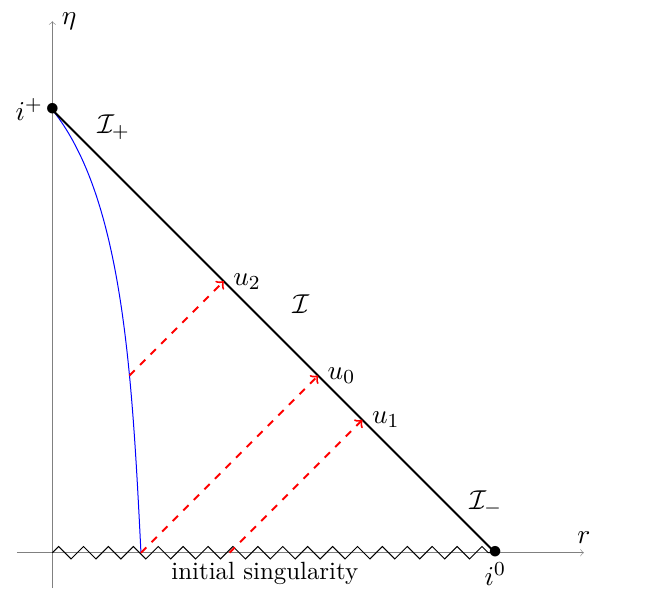
Figure 2 . A massive electrically charged particle moves along a timelike worldline (blue) and sources a radial electric field F by following a null geodesic (red, dashed line) from I backwards. For u < u possible, in contrast to flat